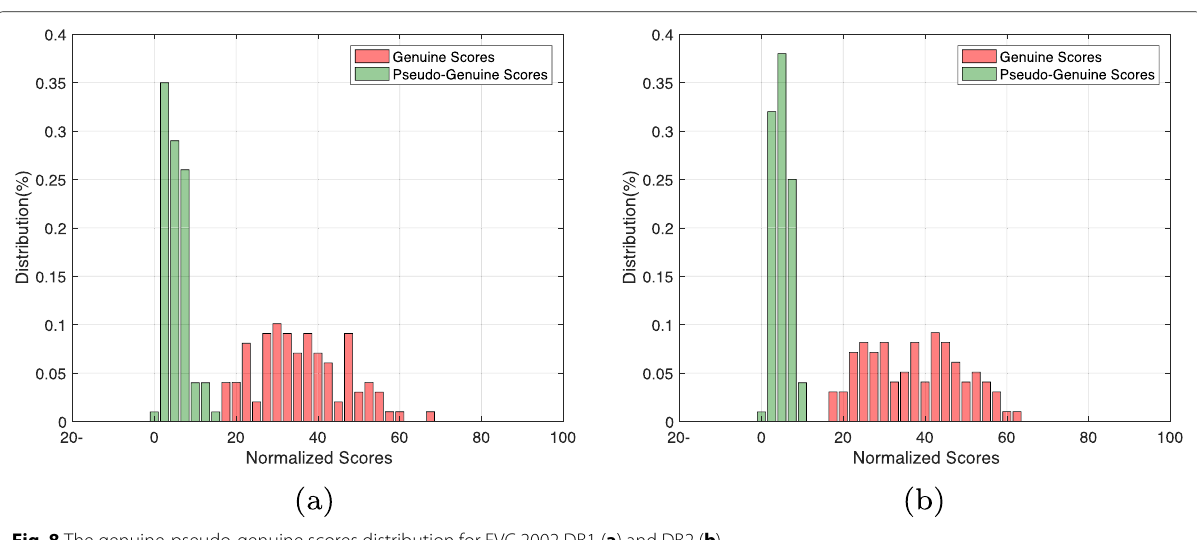
Fig. 8 The genuine-pseudo-genuine scores distribution for FVC 2002 DB1 ( a ) and DB2 ( b